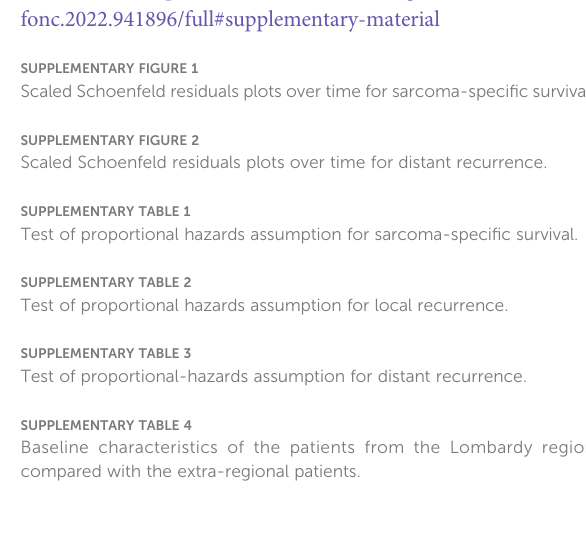
SUPPLEMENTARY FIGURE 2 Scaled Schoenfeld residuals plots over time for distant recurrence. SUPPLEMENTARY TABLE 1 Test of proportional hazards assumption for sarcoma-speci fi c survival. SUPPLEMENTARY TABLE 2 Test of proportional hazards assumption for local recurrence. SUPPLEMENTARY TABLE 3 Test of proportional-hazards assumption for distant recurrence. SUPPLEMENTARY TABLE 4 Baseline characteristics of the patients from the Lombardy region compared with the extra-regional